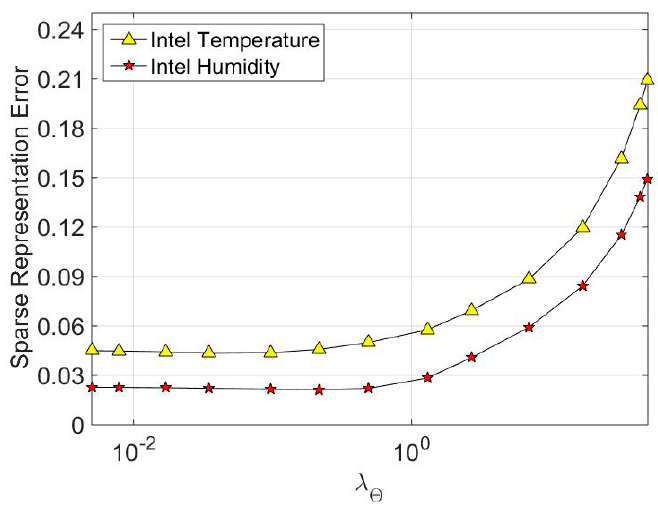
Figure 4. The impact of structured dictionary regularization parameter λ Θ on sparse representation error.